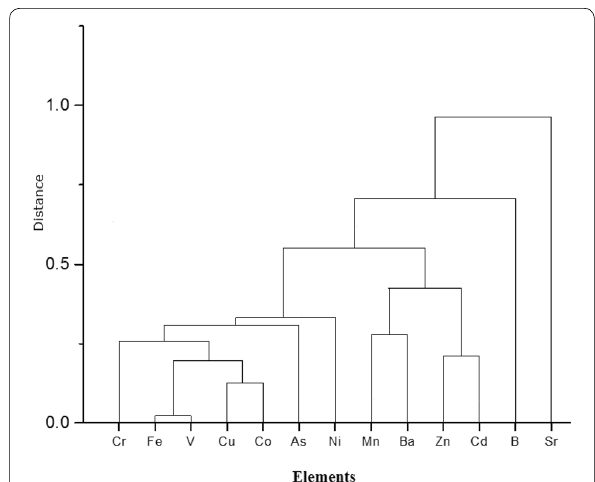
Fig. 3 Dendrogram from the cluster analysis of 13 PTEs in vegetables